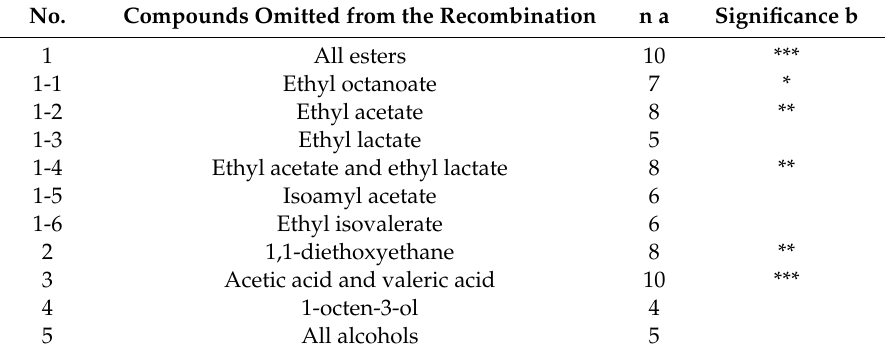
Table 5. Omission experiments of the aroma compounds from